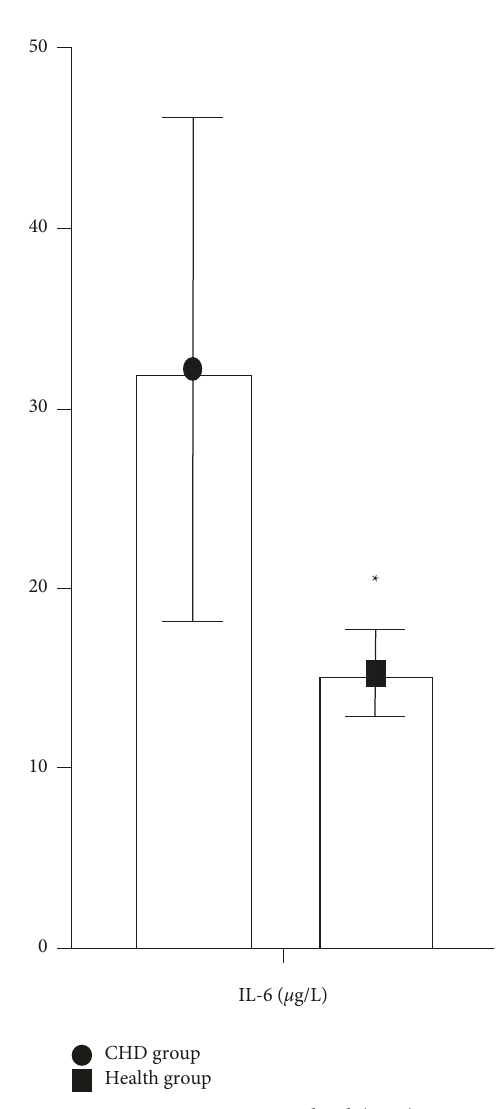
Figure 1: Serum CRP level (mg/L).